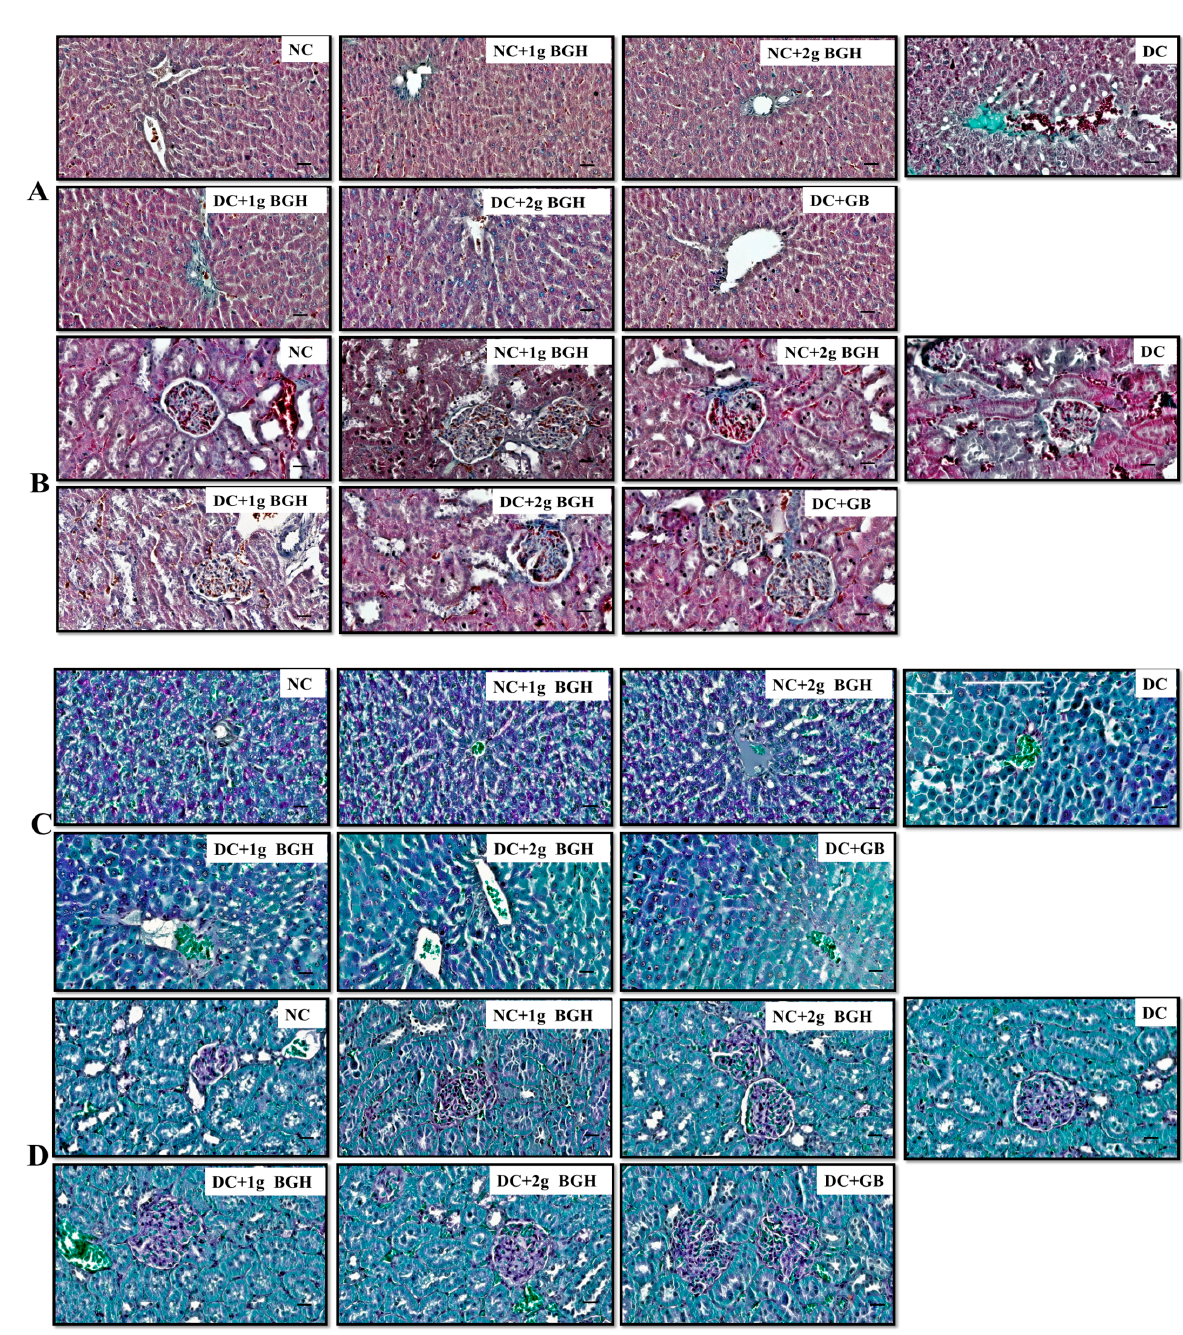
Figure 4. BGH effect on histopathological differences in the appearance of hepatic cells ( A ) and renal cells ( B ) in various experimental groups, which were stained with Masson trichrome. BGH effect on histopathological differences in the appearance of l hepatic cells ( C ) and renal cells ( D ) in various experimental groups, which were stained with Periodic acid—Schiff. Scale bar = 100 µ m. NC: Normal control; NC + 1 g BGH: Non-diabetic rats that received 1 g/kg/day